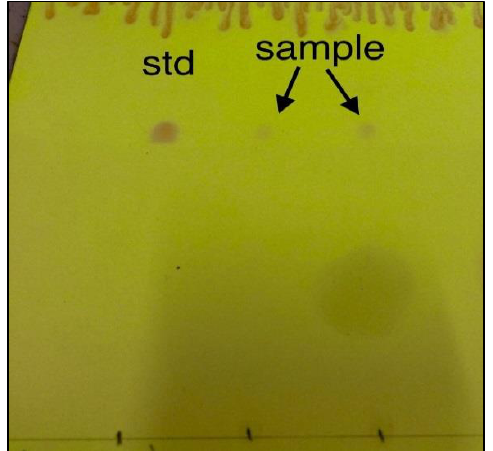
Figure 7. HPLC chromatogram of fraction one (F-1).